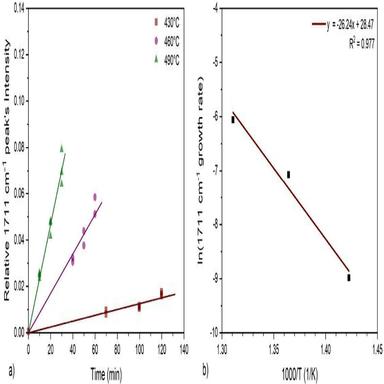
a) Growth of the 1711 cm-1 peak in PEEK as a function of the exposure time at 430, 460 and 490 ◦C and b) Arrhenius plot of the 1711 cm-1 peak's growth rate when PEEK is heated in static air conditions.